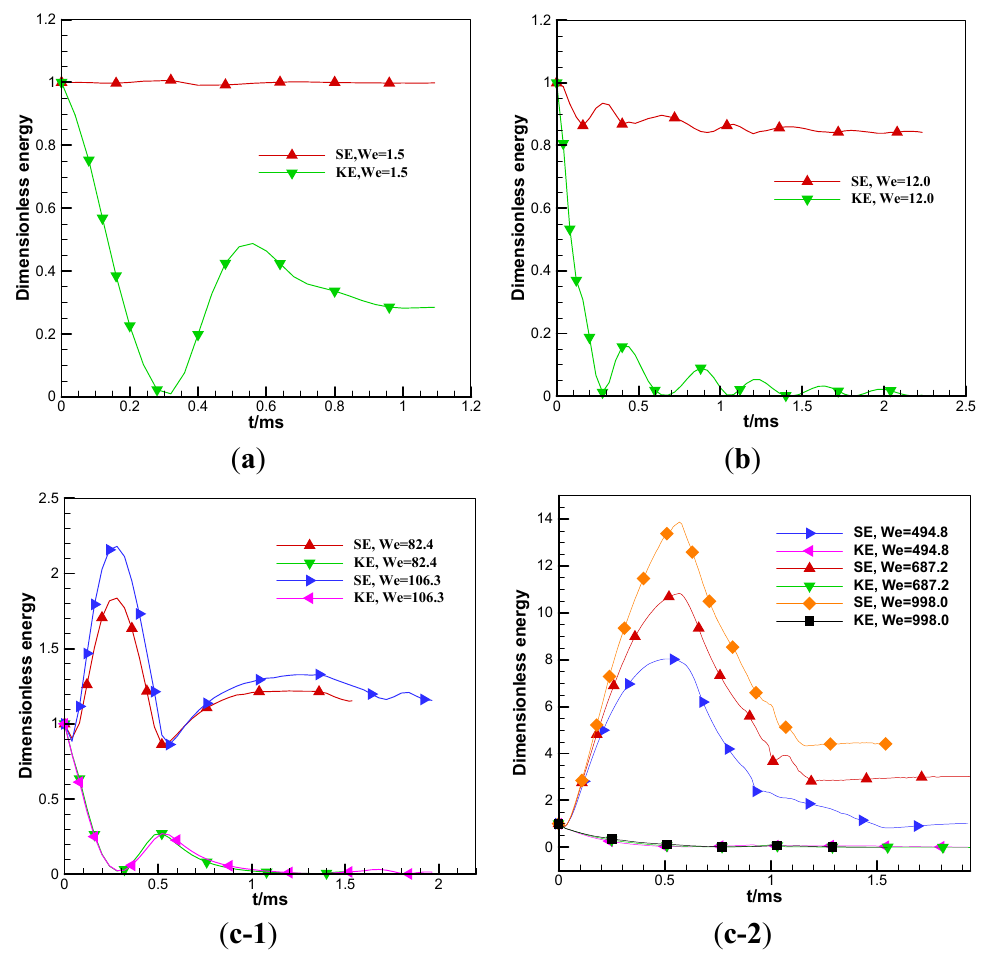
Figure 12. Temporal evolution of surface and kinetic energy for ( a ) bouncing collision, ( b ) coalescence collision, and ( c-1 , 2 ) reflexive separation collision.